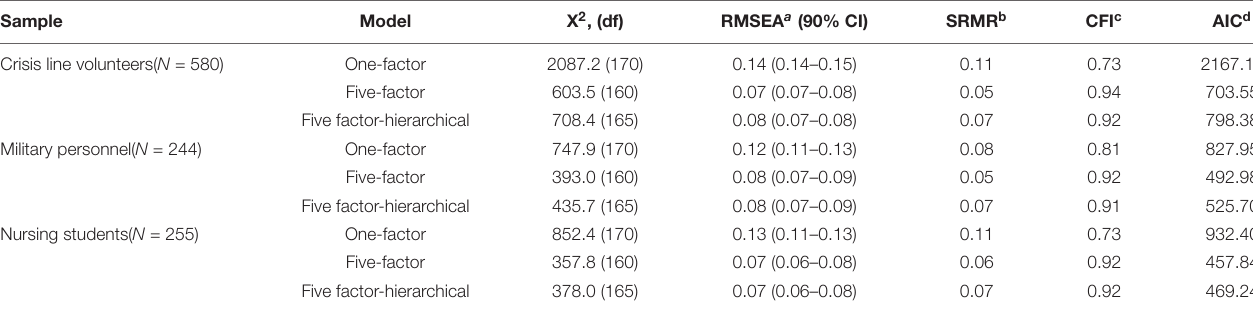
TABLE 1 | Fit indices for the self-compassion models tested in three